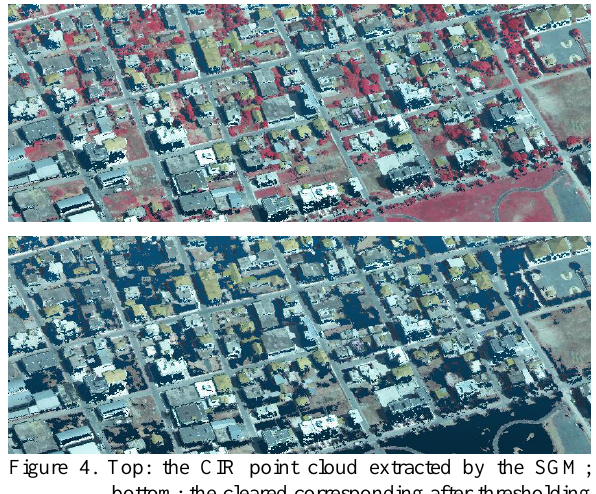
Figure 4. Top: the CIR point cloud extracted by the SGM; bottom: the cleared corresponding after thresholding the